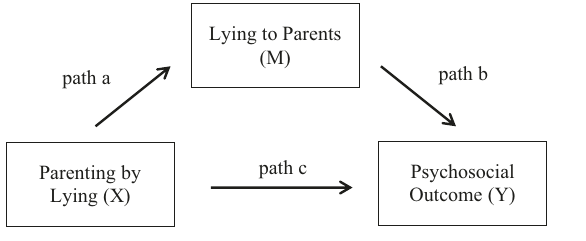
Fig. 1 Conceptual mediation model. Conceptual mediation model between exposure to parenting by lying (X), psychosocial outcomes (Y), and lying to parents (M).